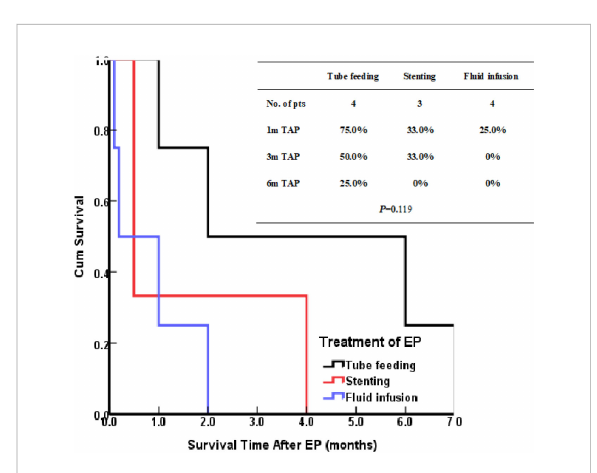
FIGURE 5 Kaplan – Meier curves for survival After EP of patients had EP during